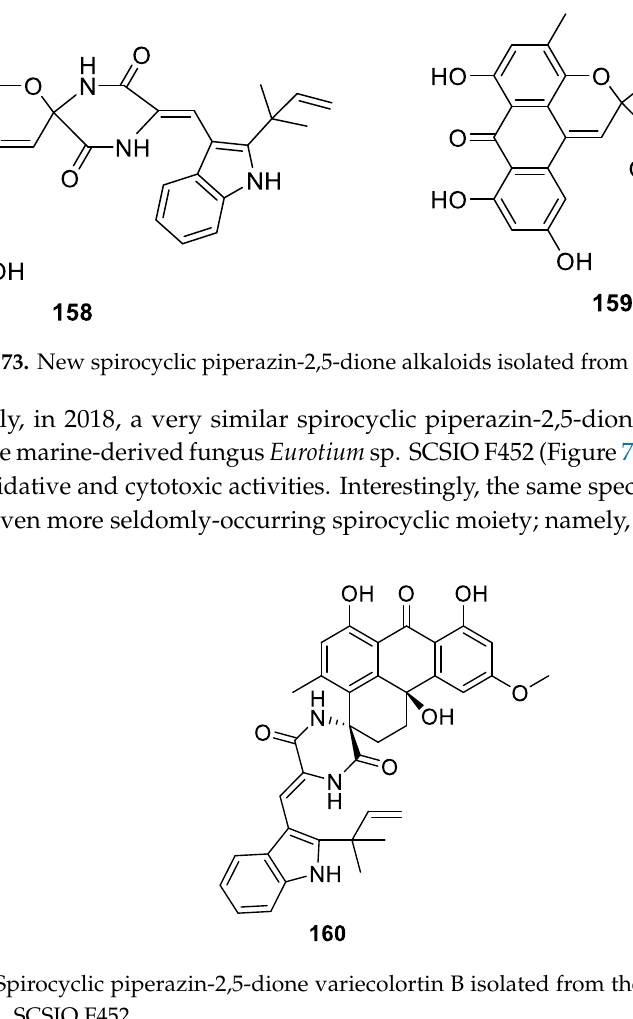
Figure 74. Spirocyclic piperazin-2,5-dione variecolortin B isolated from the marine-derived fungus Eurotium sp. SCSIO F452.